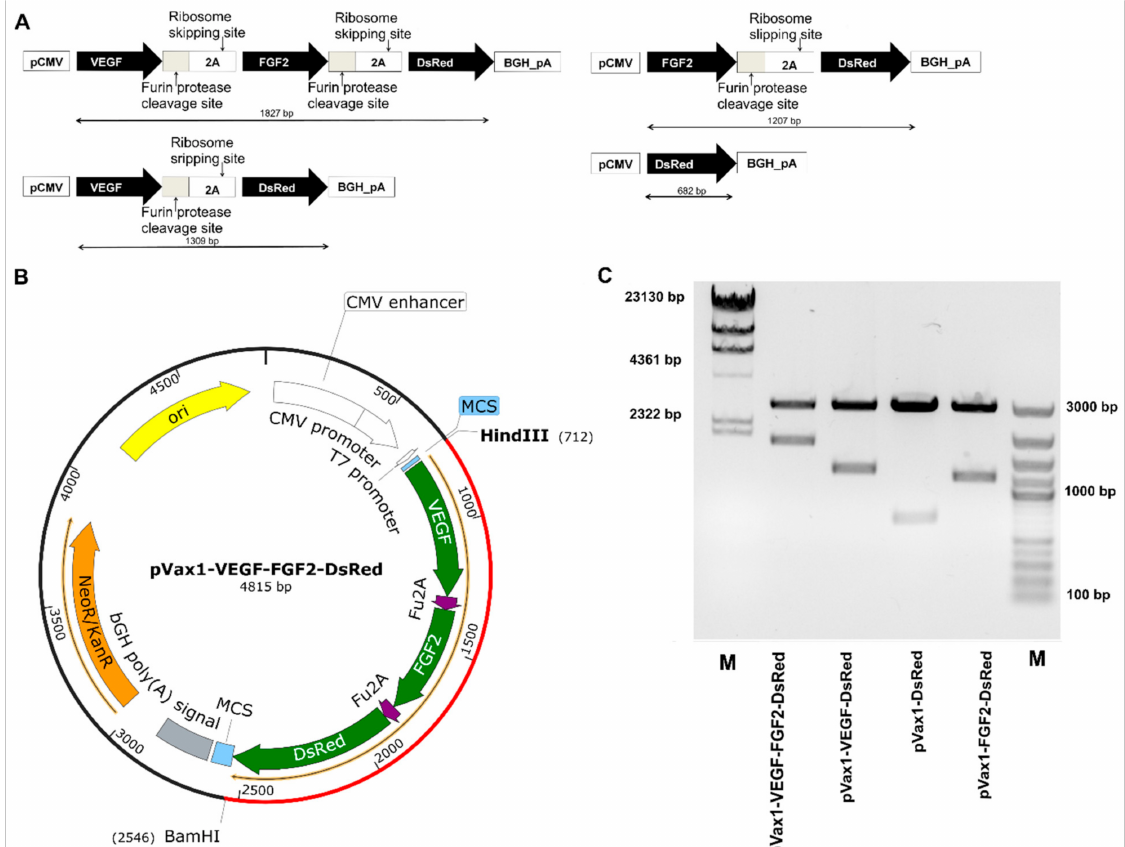
Figure 1. Design and characterization of plasmid vectors. ( A ) Schematic of the genetic cassettes, containing therapeutic genes (Vascular Endothelial Growth Factor (VEGF165), Basic Fibroblast Growth Factor (FGF2)) and reporter fluorescent protein (Red fluorescent protein (DsRed)). ( B ) Schematic diagrams of the expression vectors. ( C ) Analysis of enzymatic digestion. Agarose gel electrophoresis. M—marker/HindIII (SM0103) and GeneRuler DNA LadderMix